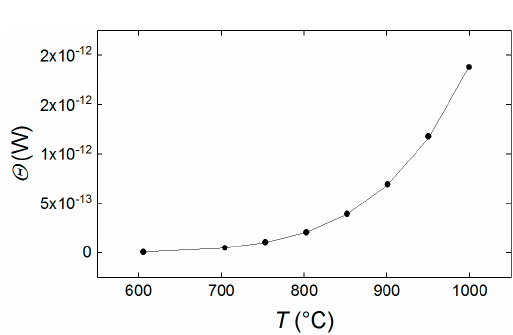
Figure 9. Calibration curve for 1.5 ms exposure time showing an exponential dependency of irradiant flux ( Θ ) upon temperature at the operating wavelength. The points are measured values at an assumed spatial frequency of zero and the line is the best fit of the Sakuma Hattori calibration curve with an assumed ε * value of 0.998.